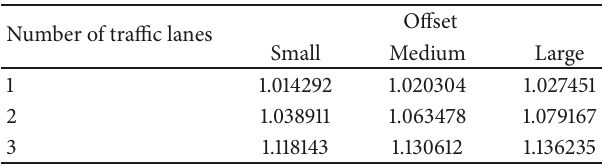
Table 4: Adjustment factor values of guideline markings for through